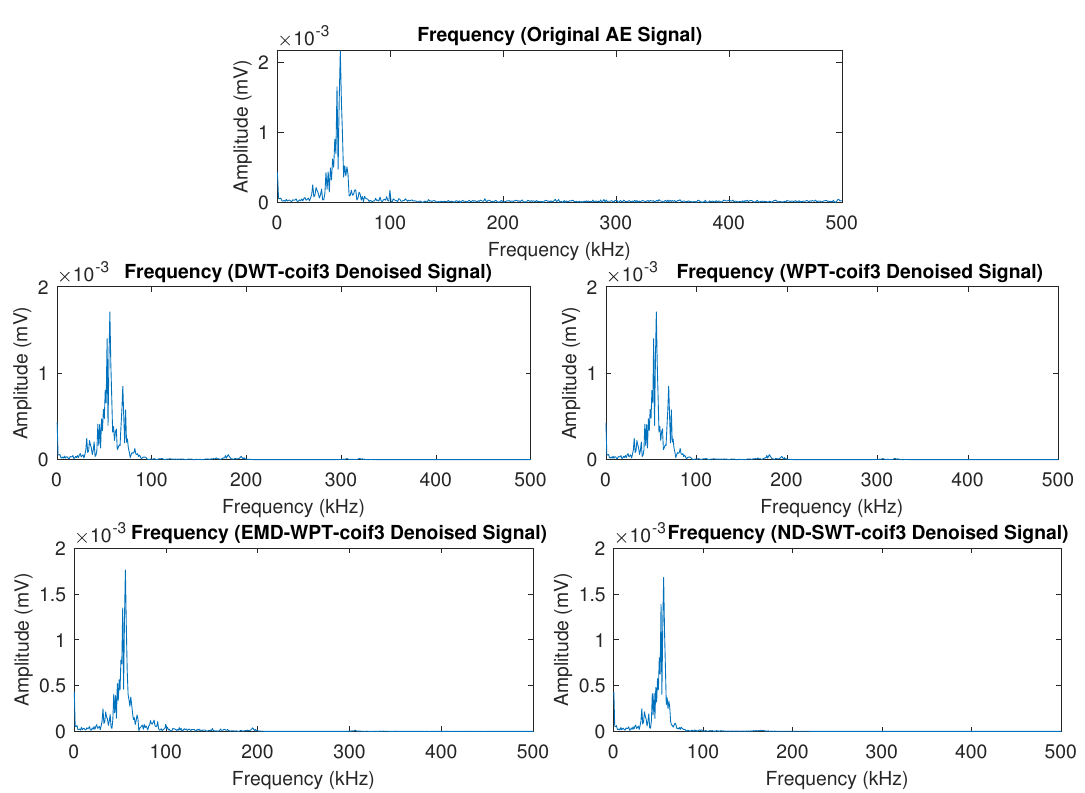
Figure 16. Frequency spectrum of AE signal after noise reduction by DWT, WPT and EMD-WPT and ND-SWT